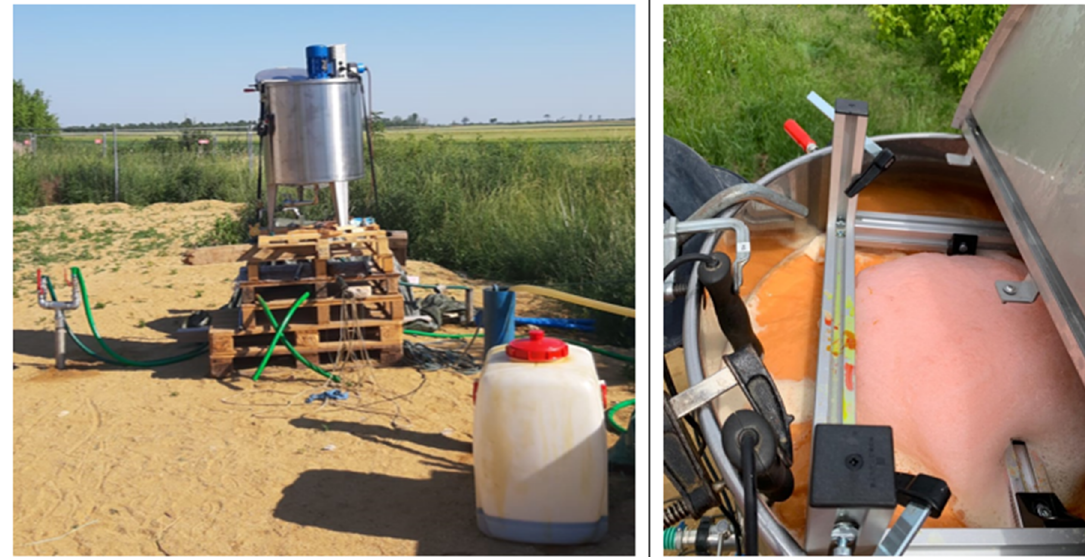
Figure 4. Setup of the field trials. Left : 300 L stainless steel mixer. Right : Close-up of the emulsion. It was colored for better visibility.